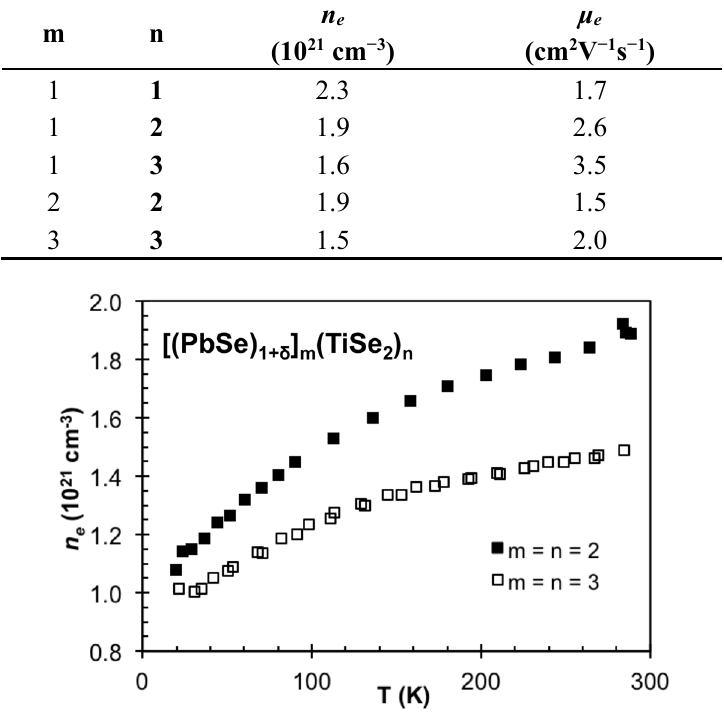
Figure 16. Temperature dependent carrier concentration (n e ) for the m = n = 2 and 3 compounds, suggesting that the upturn in resistivity is in part due to a decrease in carriers.